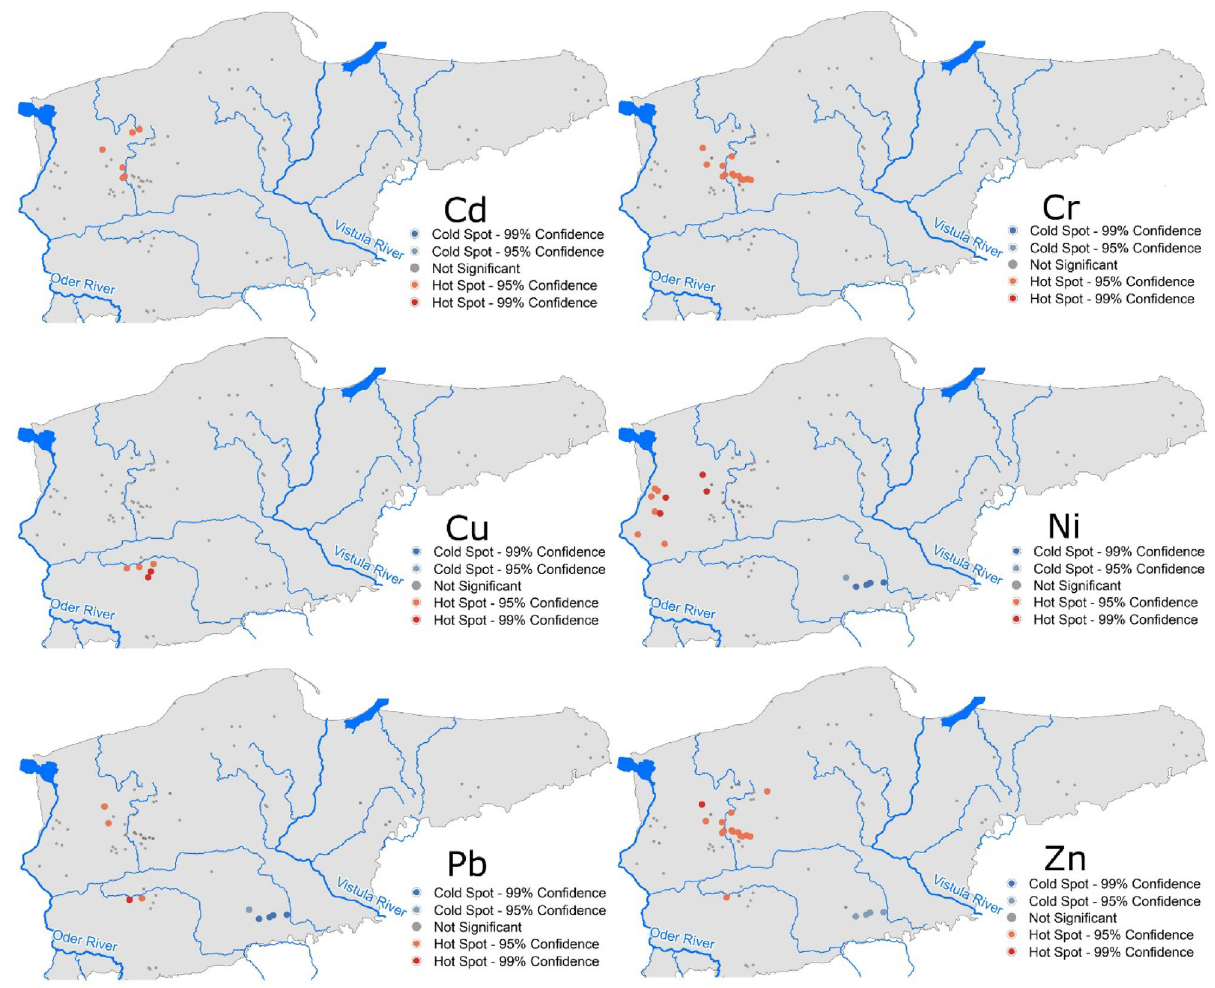
Figure 8. Occurrence of hot and cold spots in lakes in terms of the content of particular HMs in surface sediments (the figure was generated in ArcMap 10.7, https:// deskt op. arcgis. com/ en/